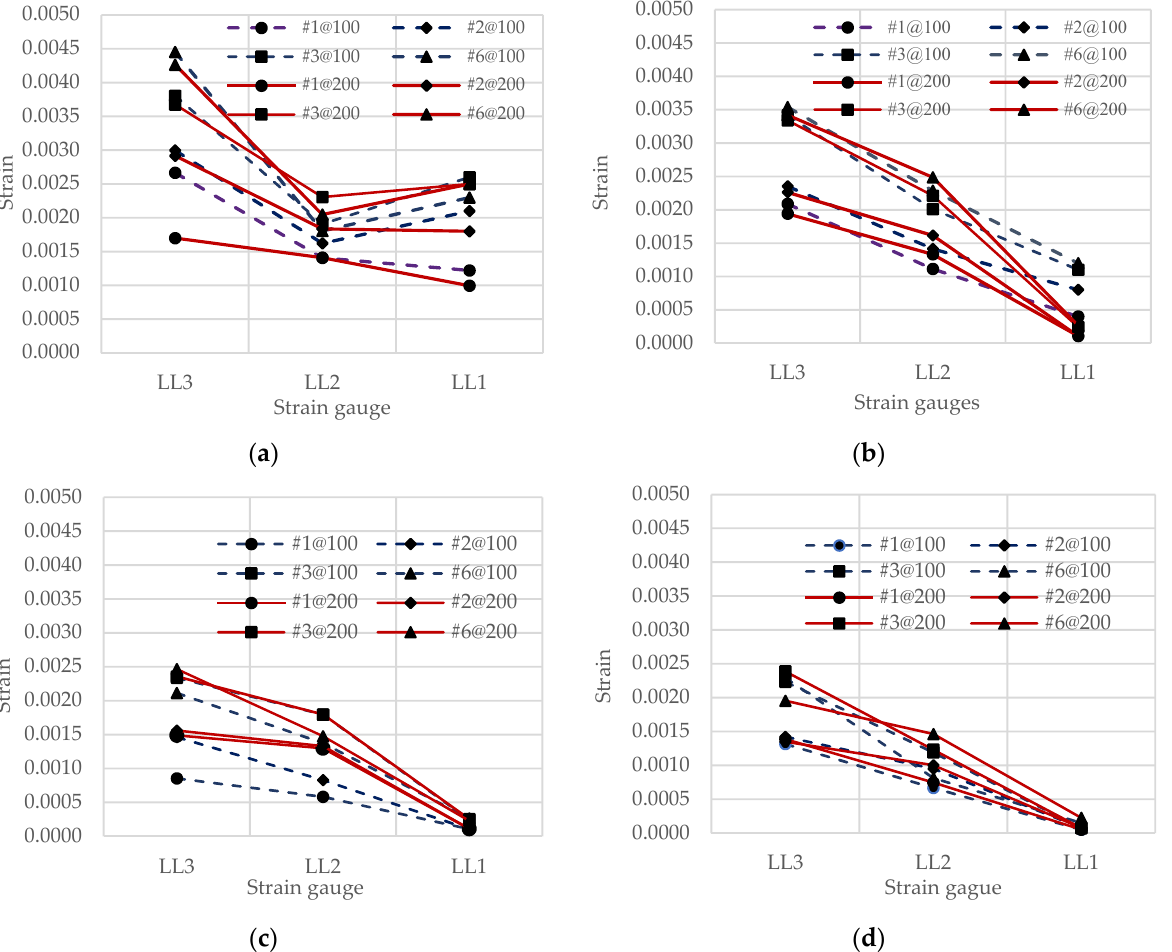
Figure 6 . Strains of longitudinal reinforcements: ( a ) specimens I00-1 and I00-2, ( b ) specimens I14-1 and I14-2, ( c ) specimens I21-1 and I21-2, and ( d ) specimens I28-1 and I28-2.